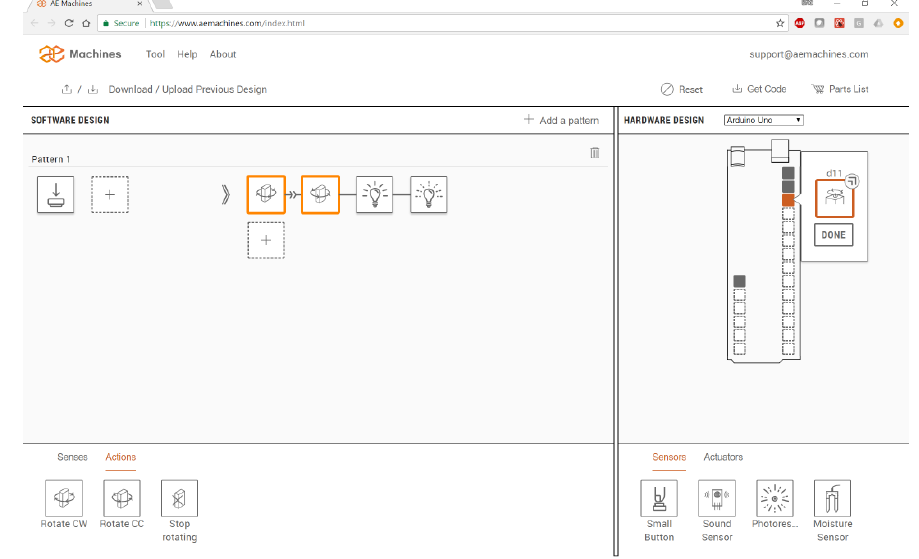
Figure 1. Easy-to-use hardware coding interface developed by AE Machines, Inc., which leverages choreographic abstractions regarding movement design and enables